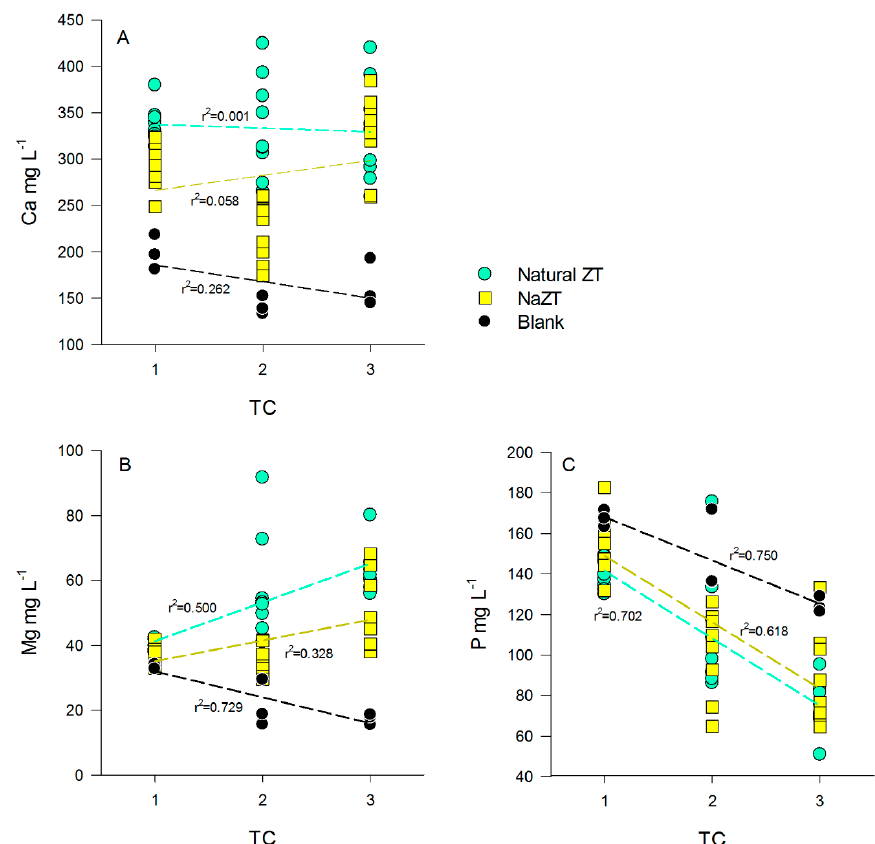
Figure 5. Relationship between Ca 2 + ( A ), Mg 2 + ( B ), and P ( C ) vs. the number of treatment cycles (TC) in the treated pig-slurry (PS). Black dots and black regression lines represent blank samples (no ZT added), cyan dots and regression lines to natural ZTs (all the grain sizes), while yellow squares and regression lines to NaZTs (all the grain sizes).